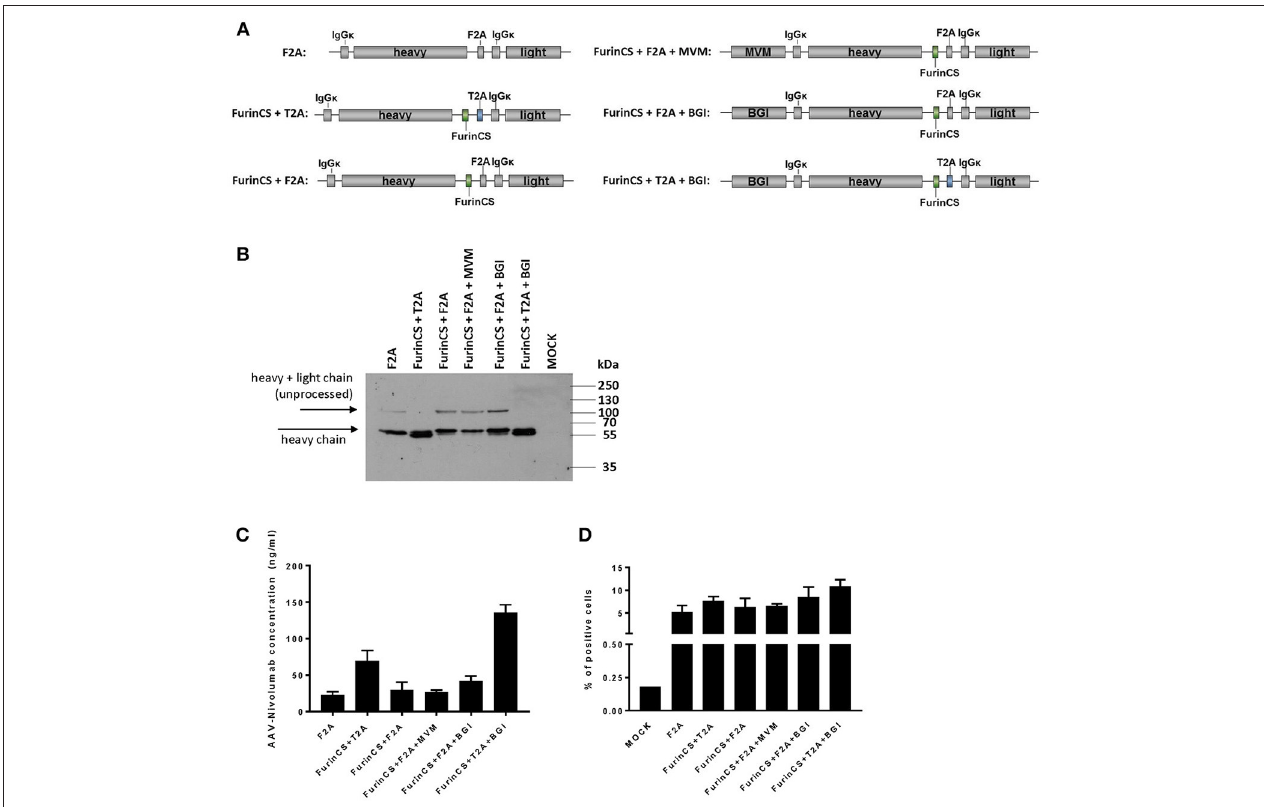
FIGURE 8 | Optimization of nivolumab expression and processing. (A) Schematic drawings of optimized nivolumab expression constructs for AAV2 transfer vectors. All vector constructs were under control of the SFFV promoter. F2A, foot and mouth disease virus-derived self-cleaving protein sequence; T2A, thosea asigna virus-derived self-cleaving protein sequence; FurinCS, furin cleavage site; MVM, minute virus of mice intron; BGI, β -globin intron; IgG κ signal peptides are fused to the N-terminal ends of heavy and light chain. (B) Four days after transduction of MDA-MB-453 cells with small-scale preparations of AAV2 vector encoding the different constructs (500,000 genome copies/cell), cell culture supernatants were collected and analyzed by Western blot analysis using an IgG-Fc-specific antibody. AAV2 GFP -transduced cells served as control (MOCK). (C) AAV-encoded nivolumab released into the vector transduced MDA-MB-453 cell culture supernatant was assessed by sandwich ELISA using plates coated with recombinant PD-1 and an IgG-Fc-specific detection antibody. (D) Specific antigen recognition was evaluated on PD-1 positive cells (MOLT4.8) by flow cytometry. The binding of nivolumab was detected via an IgG-Fc-specific antibody. MOLT4.8 cells were treated with supernatant of AAV2 IgG − Fc transduced cells (MOCK). All datasets in (C,D) n = 3 (mean ±